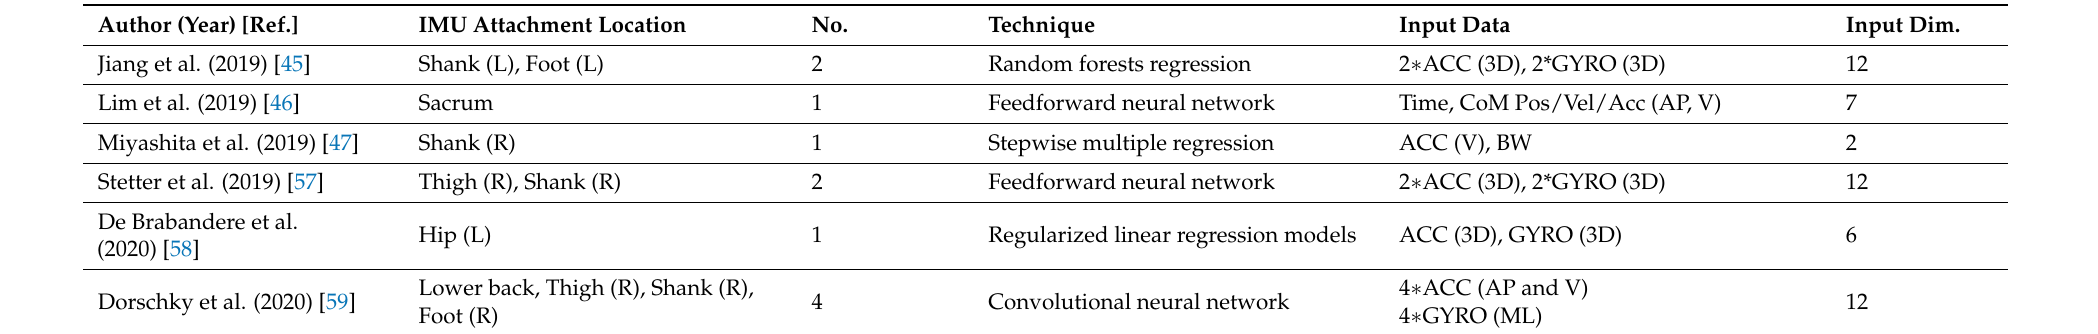
Table 4. Summary of machine learning-based